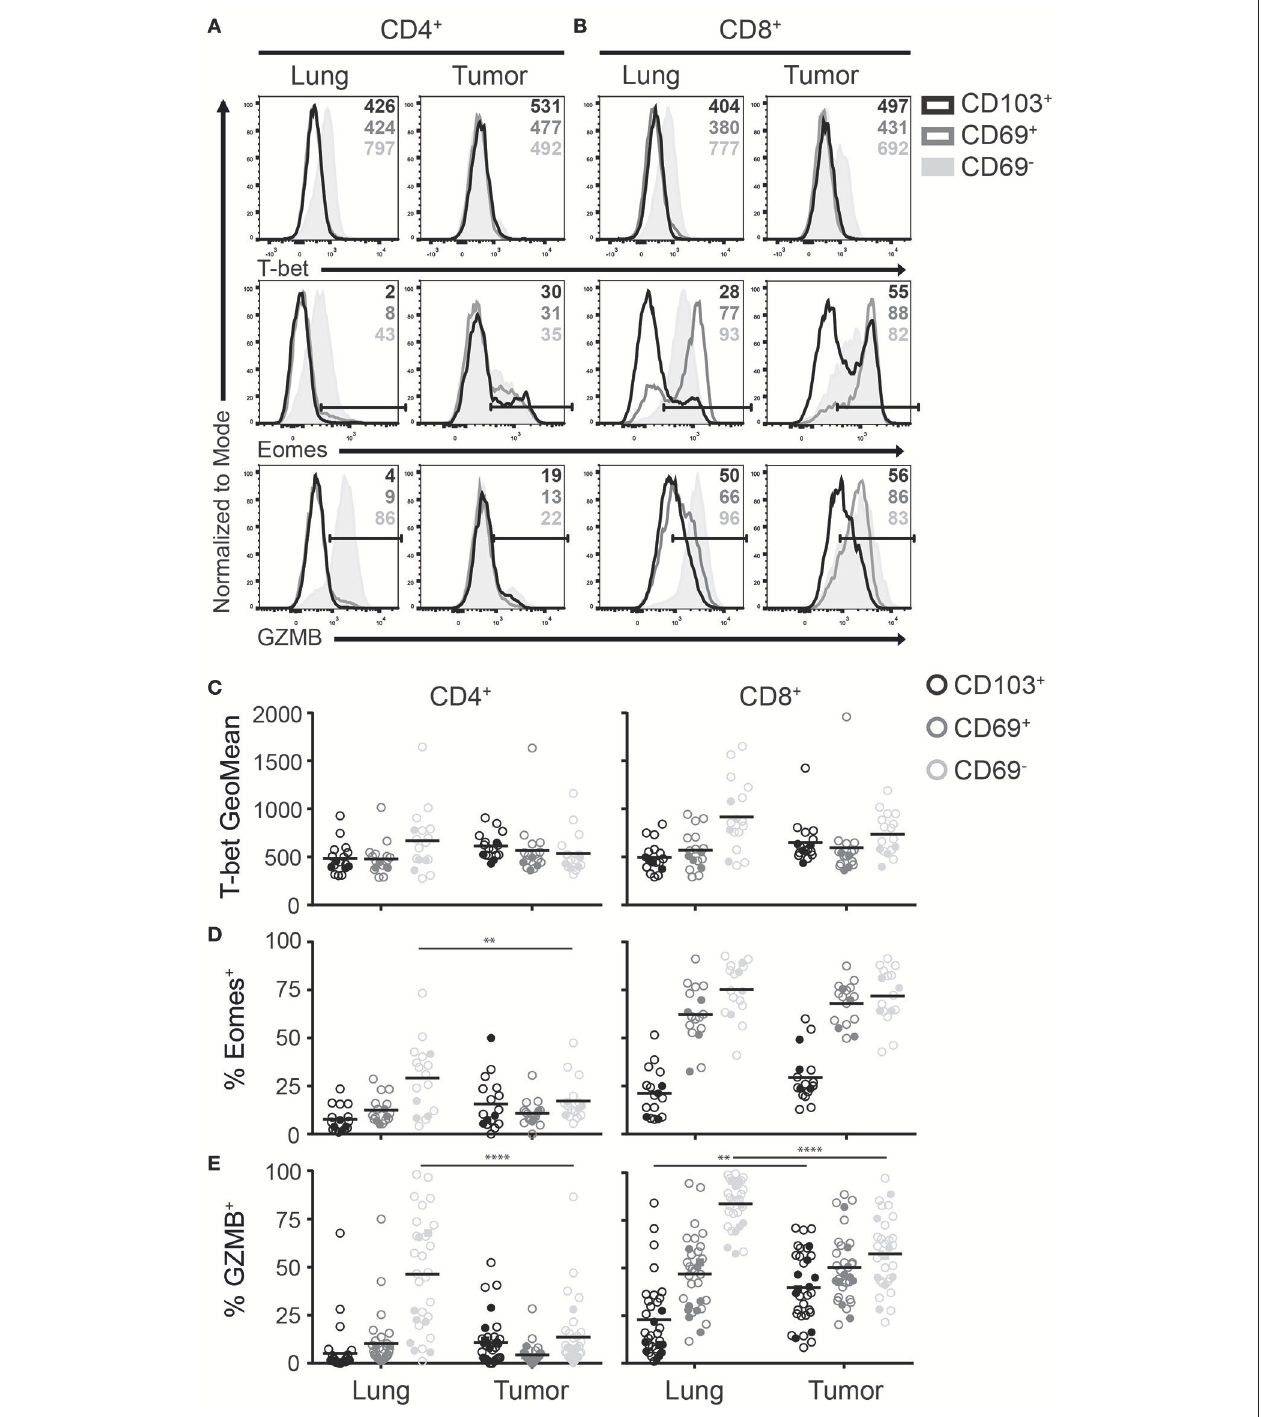
FIGURE 4 | Expression of T-bet, Eomes and GZMB on T RM and TILs. (A–D) The expression of T-bet, Eomes, and GZMB was analyzed on CD4 + and CD8 + T RM and TILs. The expression of T-bet (top panels), Eomes (middle panels), and GZMB (bottom panels) on lung (left panels) and tumor (right panels) CD4 + (A) and CD8 + (B) T cells is shown by representative histogram overlays (maximum set to 100%) (CD103 + black, CD69 + dark gray, CD69 − solid light gray). The expression of T-bet (geometric mean fluorescence intensity; GeoMFI) (C) and frequencies of Eomes + (D) and GZMB + (E) CD103 + (black circles), CD69 + (dark gray circles), and CD69 − (light gray circles) cells of lung and tumor CD4 + (left graphs) and CD8 + (right graphs) T cells. (C–E) The quantifications are shown as dot plots with the horizontal line indicating the mean and each point represents a unique sample. n = 17. Open circles and solid circles indicate adeno- and squamous carcinoma, respectively. ** p < 0.01, **** p < 0.0001; 2-way ANOVA with Tukey’s multiple comparisons test.